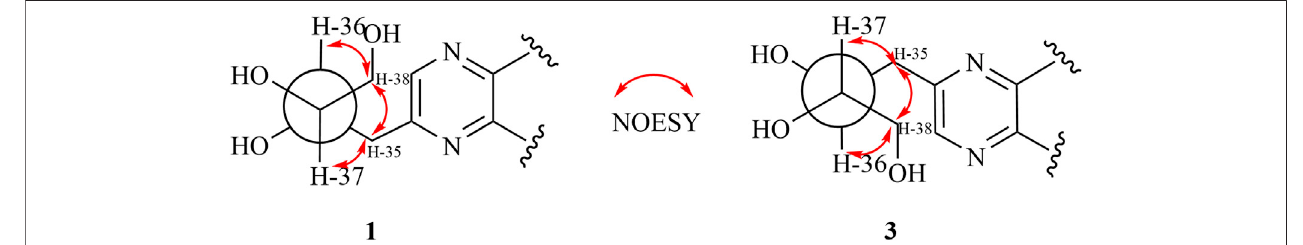
FIGURE 3 | Threo-con fi guration of compound 1 .